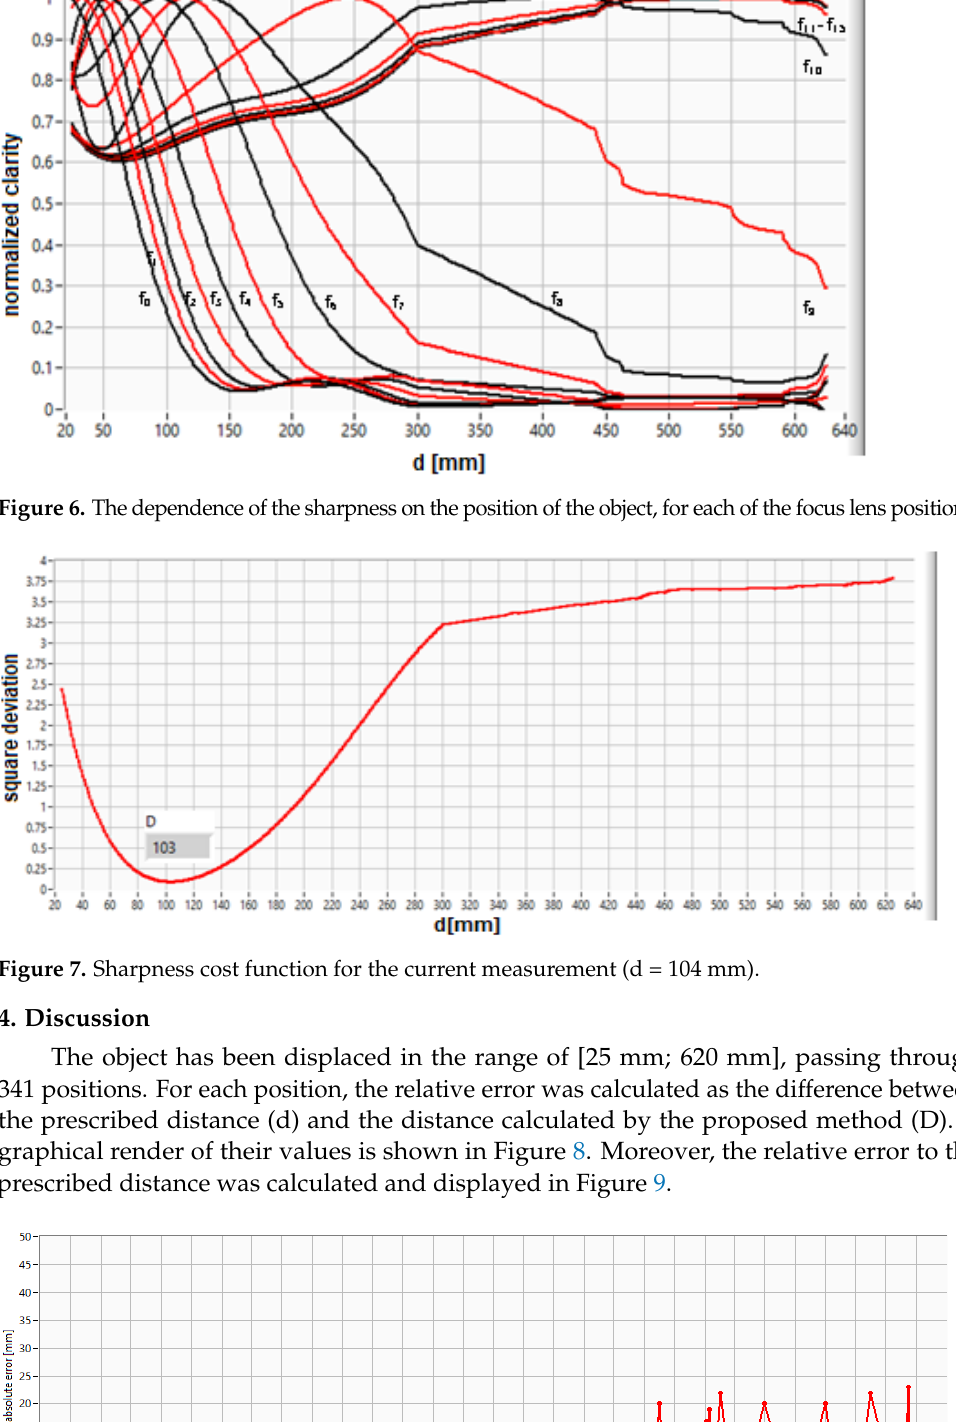
Figure 8. The graphical variation of absolute errors on distance.